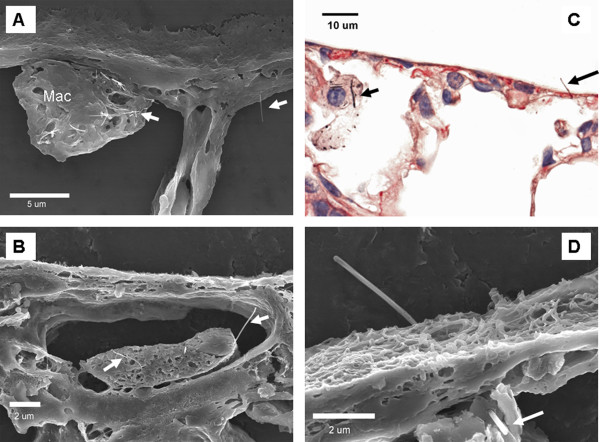
Representative micrographs of MWCNT in subpleural tissues, visceral pleura and pleural space. In all four panels, the visceral pleural surface runs along the top of each micrograph. The FESEM image in A shows a MWCNT loaded alveolar macrophage in an alveolus immediately beneath the visceral pleura surface. The right side of the image shows a single MWCNT fiber penetrating the alveolar epithelium into the subpleural tissues (80 μg dose, 28 day post-aspiration). Figure 7B shows a dilated subpleural lymphatic vessel which contains a mononuclear inflammatory cell that is penetrated by several MWCNT fibers (80 μg dose, 56 day post-aspiration). A MWCNT penetrating the visceral pleura is shown in the light micrograph of 7C with a MWCNT-loaded alveolar macrophage visible in the left side of the micrograph (80 μg dose, 28 day post-aspiration). A single MWCNT penetrating from the subpleural tissue through the visceral pleura into the pleural space is shown in the FESEM image of 7 D (80 μg dose, 56 day post-aspiration).